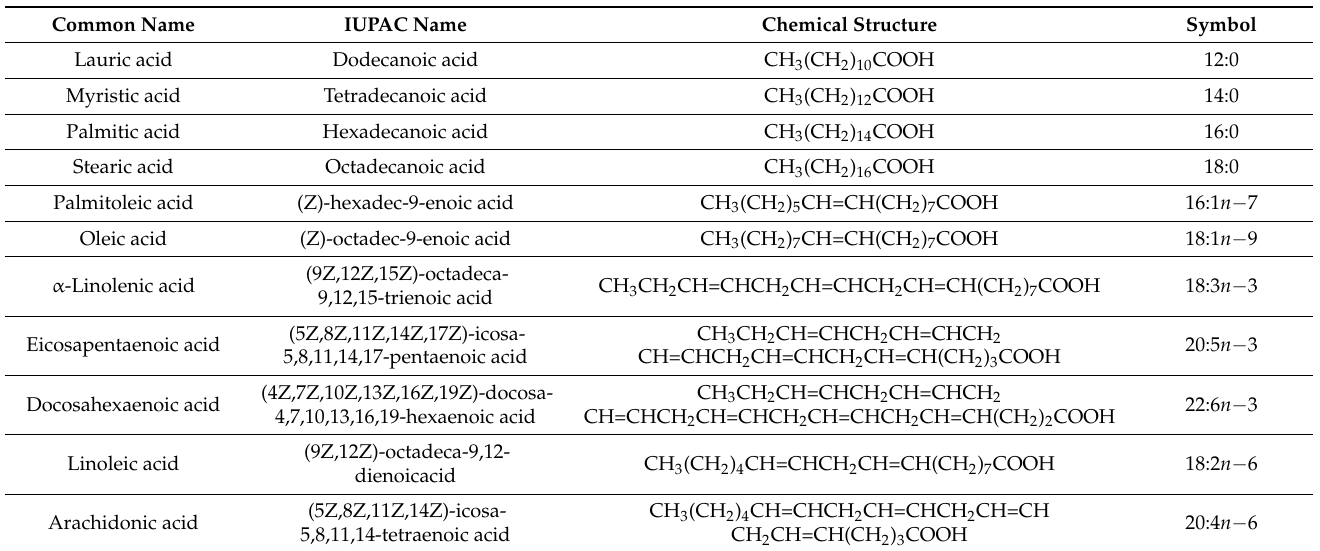
Table 1. Names, chemical structures, and symbols of the fatty acids mentioned in this